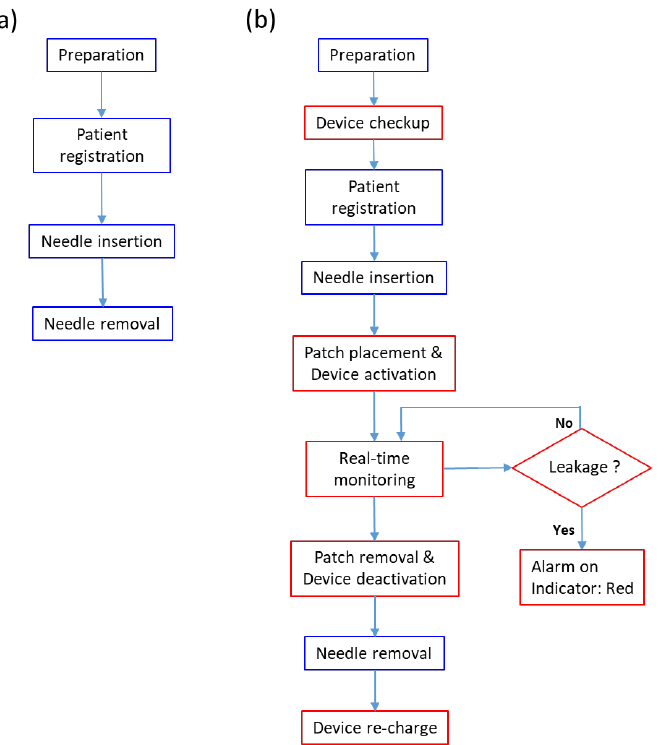
Figure 6. The operation steps ( a ) in a traditional hemodialysis session, and ( b ) in a hemodialysis session using our proposed leakage detection device. Blue boxes: standard hemodialysis steps. Red box: additional steps needed to use our leakage detection